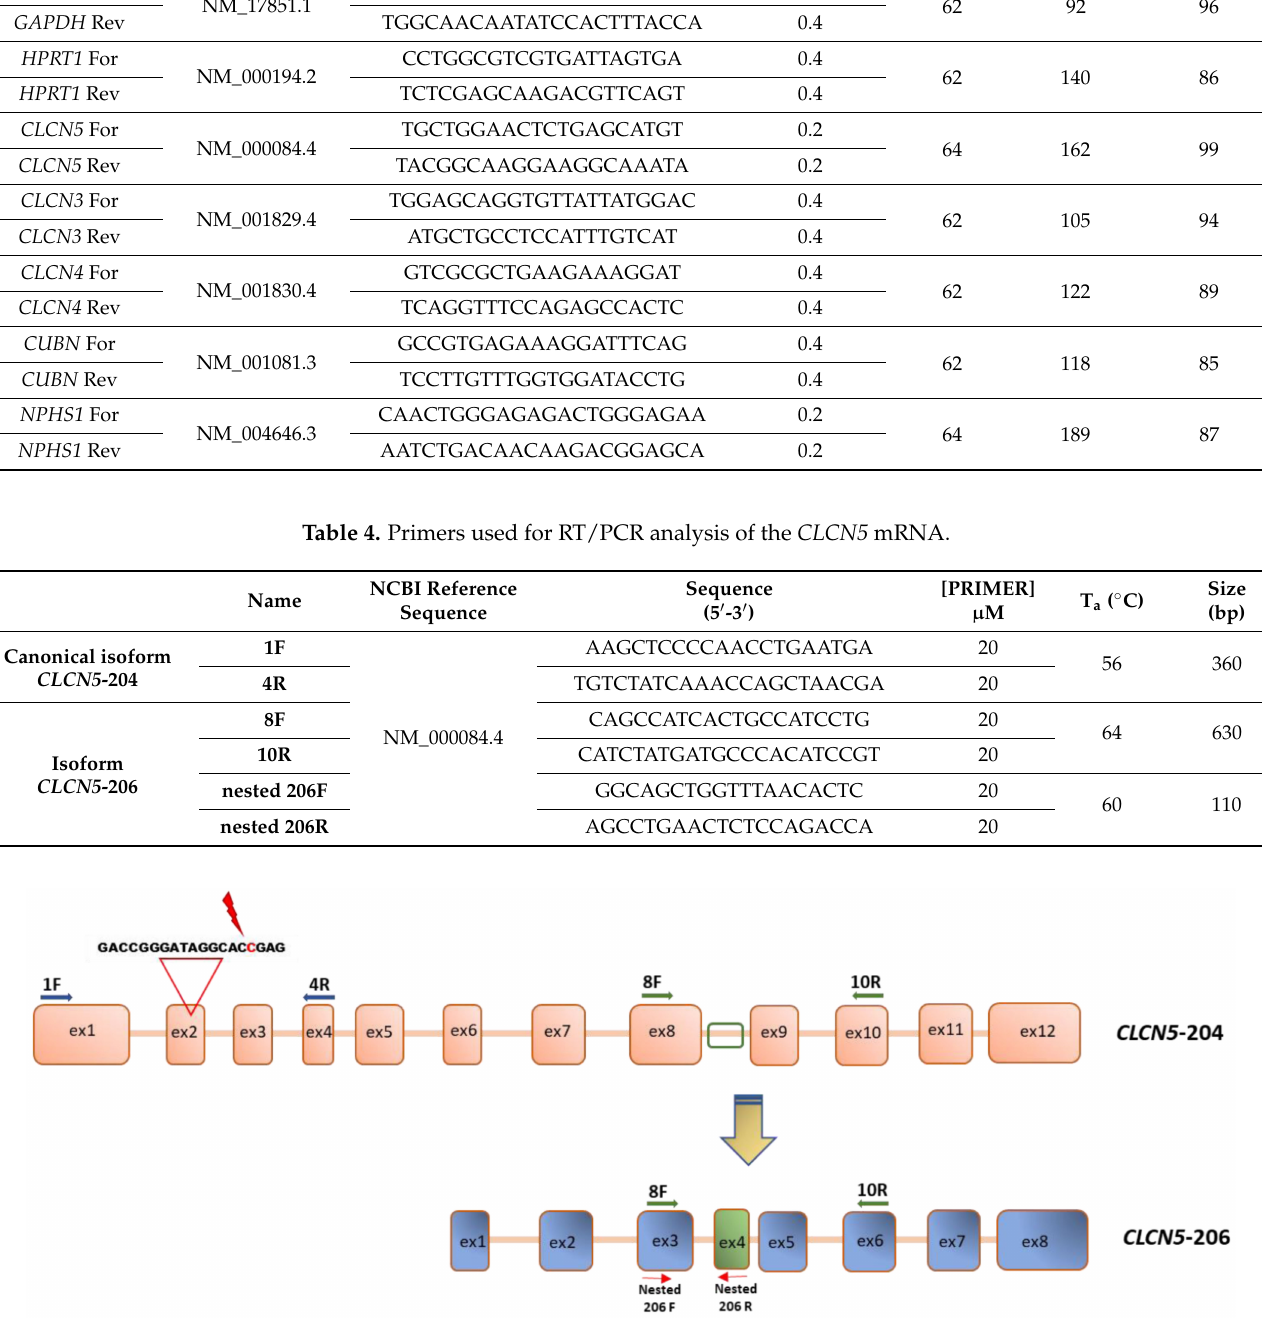
Figure 13. Schematic representation of primer localization in CLCN5 cDNA. Primer pairs 1F-4R amplify canonical CLCN5 -204 isoform; primer pairs nested 206F-nested 206R amplify only CLCN5 - 206 isoform starting from a primary amplicon obtained by a first PCR amplification with primer pairs